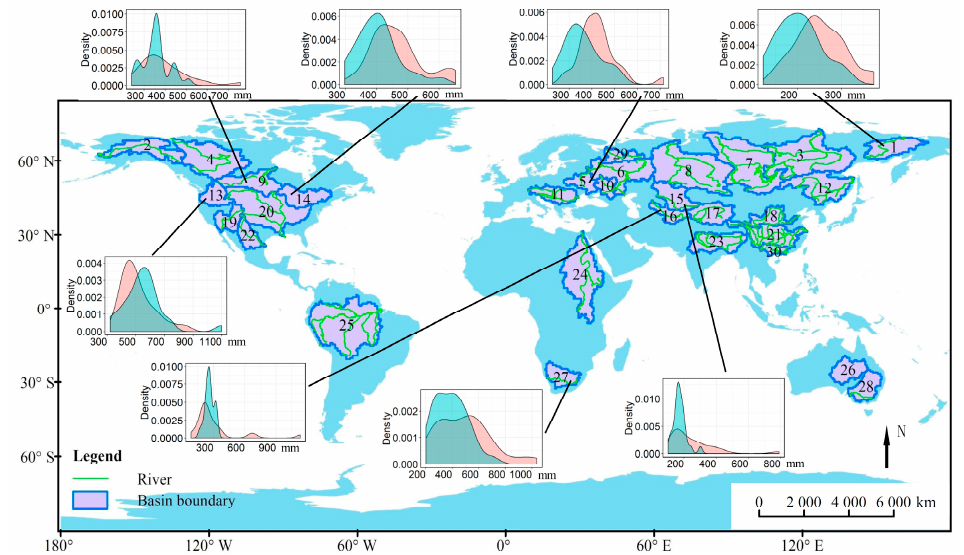
Figure 6. Changes in frequency distributions of maximum five-day precipitation RX5day for different river basins. The green and pink shadings in each panel represent the distributions for the period of 1960–1984 and 1985–2011, respectively. The x-axis in each panel shows amount of RX5day and the y-axis is the corresponding frequency distribution density.